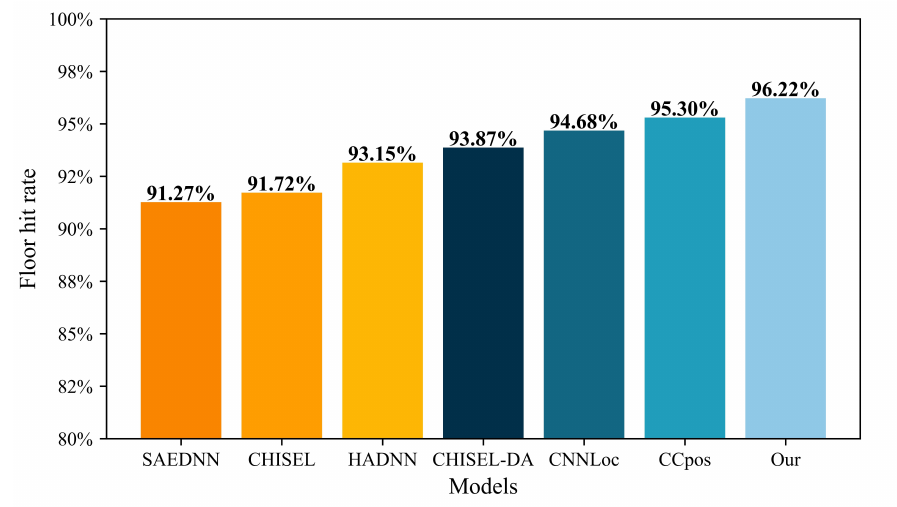
Figure 8. Comparison of our algorithm and state-of-the-art deep learning methods for multi-floor positioning.